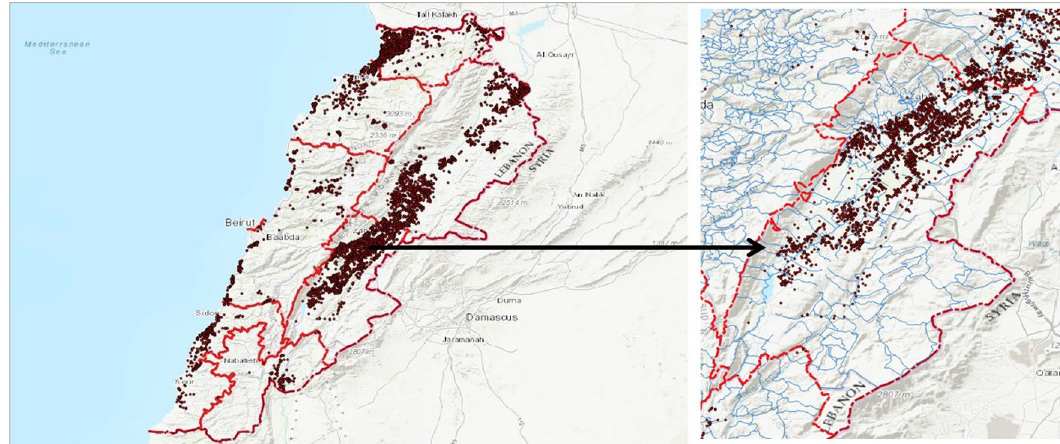
Fig.1 Informal Settlements (left) in Lebanon, (right) in the Bekaa Valley (Source: Data from UNHCR 2020, Software used: